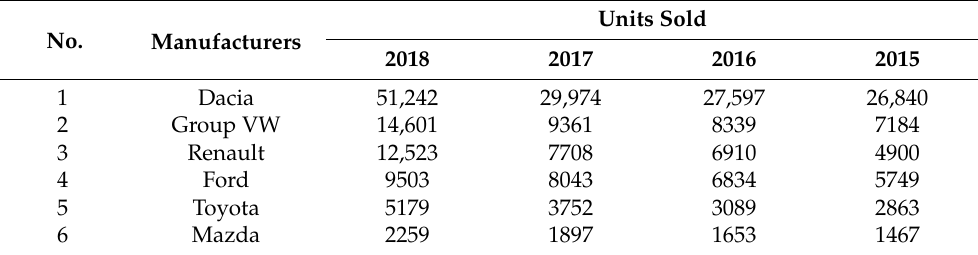
Table 5. Vehicle